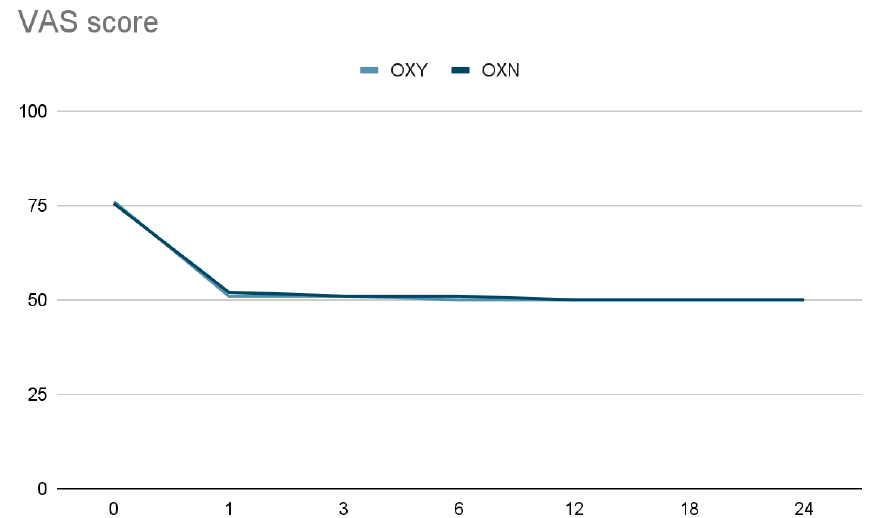
Figure 3. Distribution of VAS values (0–100) expressed in median and IQR (25–75) at the scheduled 2-year follow-up checkpoints (1, 3, 6, 12, 18, 24 months) in the two different study groups (OXY, OXN). All 43 patients reached and maintained the targeted pain relief of 30% versus baseline. OXY group: oxycodone; OXN group: oxycodone-naloxone.